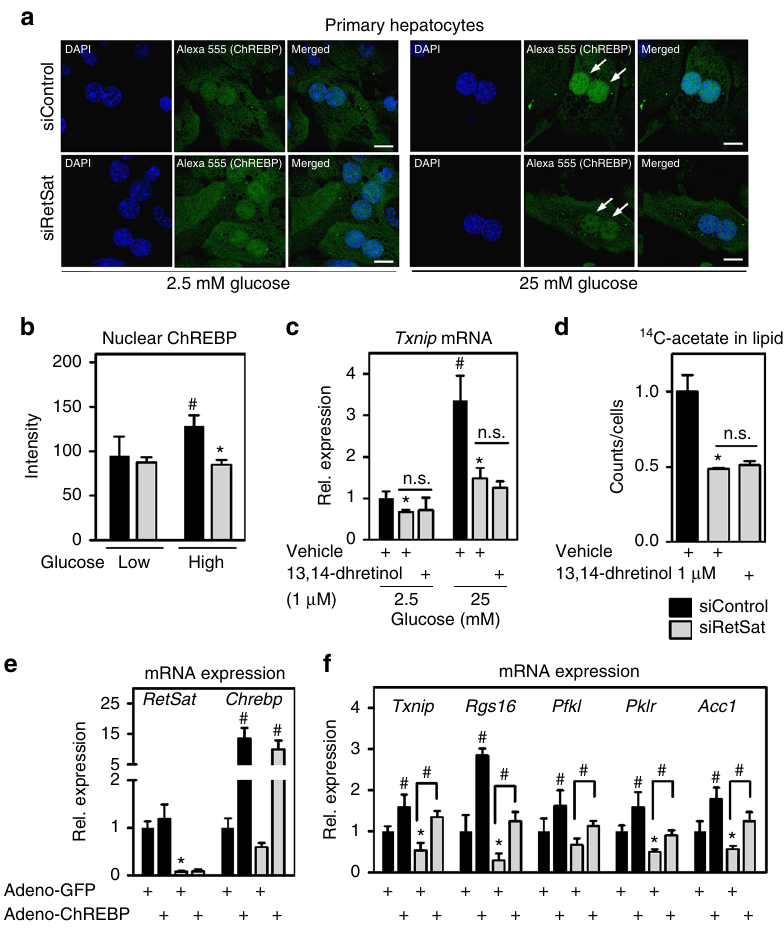
Fig. 6 RetSat depletion prevents the glucose-induced nuclear accumulation of ChREBP independent of 13,14-dihydroretinol generation. a Primary hepatocytes were seeded on cover slips in 2.5 mM glucose. 24 h later, hepatocytes were treated with Control or RetSat siRNA overnight. The next day hepatocytes were exposed to 2.5 or 25 mM glucose and insulin as indicated for 24 h. After fi xation, endogenous ChREBP was stained by immunocytochemistry and its localization determined by confocal microscopy. Nuclei were stained using DAPI, scale bars = 20 µ m. Representative images of three independent experiments are shown. b Quanti fi cation of nuclear staining. Data are shown as mean ± s.d., n = 6 random optical fi elds of averaged nuclei intensities (total of > 15 nuclei for each condition) from hepatocyte cultures from the same mouse; two-way ANOVA with Bonferroni post test revealed signi fi cances between low and high glucose ( # P < 0.05) and between siControl and siRetSat (* P < 0.05). c Hepatocytes were treated with Control or RetSat siRNA overnight. The next morning, cells were incubated with vehicle (DMSO) or 1 µ M 13,14-dhretinol for 24 h at the indicated glucose concentrations and mRNA expression of Txnip determined by qPCR. Data are shown as mean ± s.d., n = 4. Two-way ANOVA with Bonferroni post test revealed signi fi cances between low and high glucose ( # P < 0.05) and between siControl and siRetSat (* P < 0.05), treatment with 13,14-dhretinol had